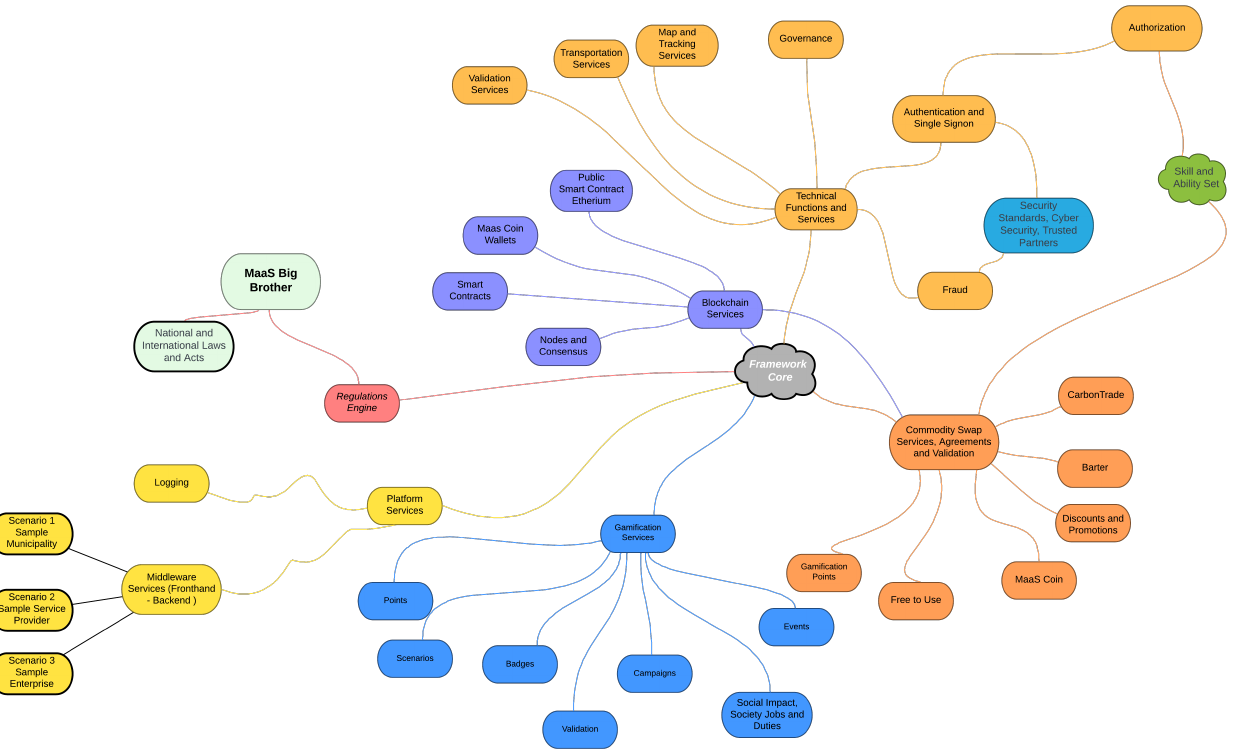
Figure 2. Framework functional